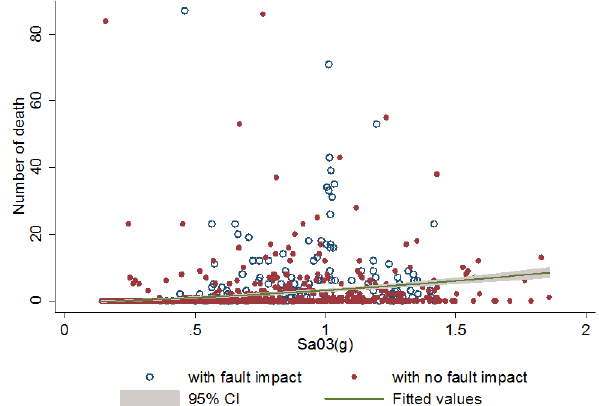
Figure 2. Sa03 and fatalities at the village level in the 1999 Chi-Chi earthquake. Notes: Blue hollow spot refers to the villages with fault impact; red spot refers to those without fault impact. The fitted line refers to the exponential relationship between Sa03( g ) and number of